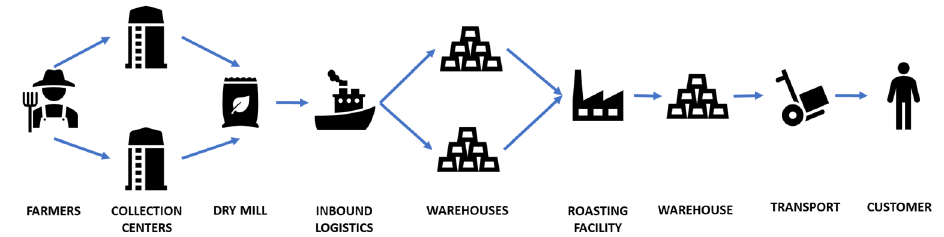
Figure 3. Visualization of the Folgers coffee supply chain.